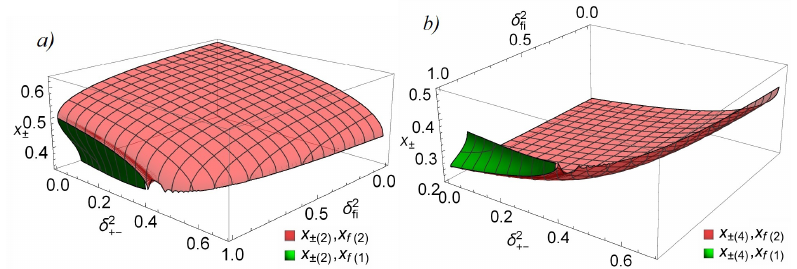
(cid:16) (cid:17) δ 2 , δ 2 + − (see Expressions (23) and (24)) on the outgoing fi